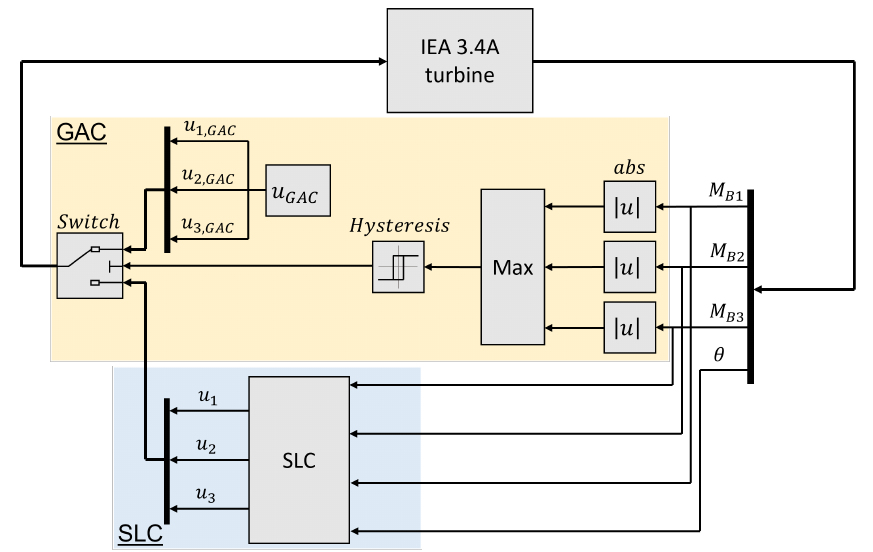
Figure 6. Block diagram of GAC and SLC with hysteresis switching logic commanded by maximum absolute values of flapwise bending moments. SLC from